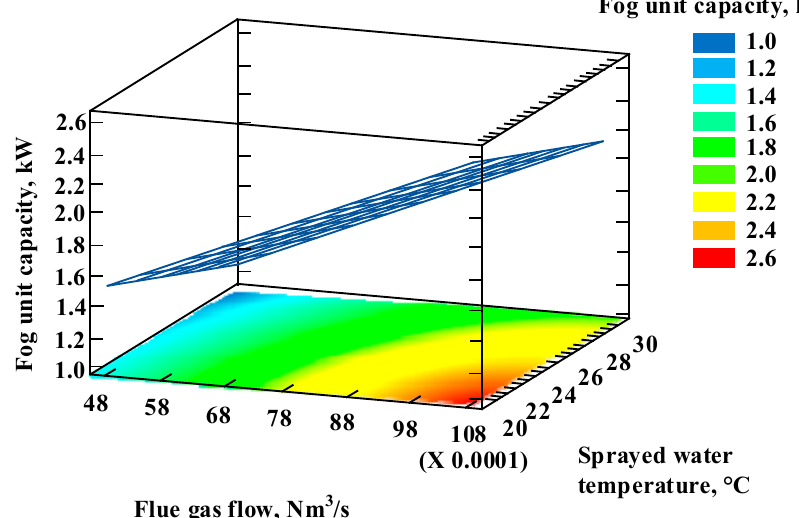
Figure 4. Capacity of the fog unit ( Q fu ) response surface depending on varying gas volumetric flow rate ( V g ) and water temperature ( t w1 ) values.